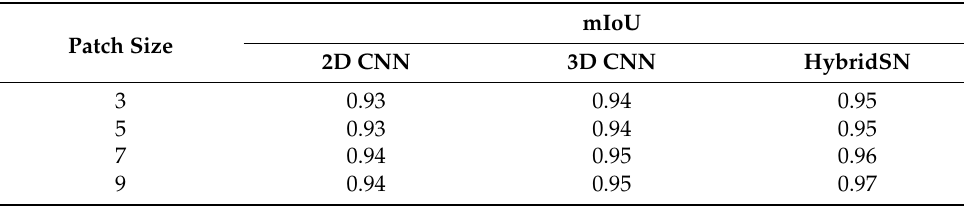
Table 7. Accuracy assessment based on mIoU of the proposed classification under different CNN models using patch sizes from 3 × 3 to 9 × 9. mIoU Patch Size 2D CNN 3D CNN HybridSN 3 0.93 0.94 0.95 5 0.93 0.94 0.95 0.94 0.95 0.96 0.94 0.95